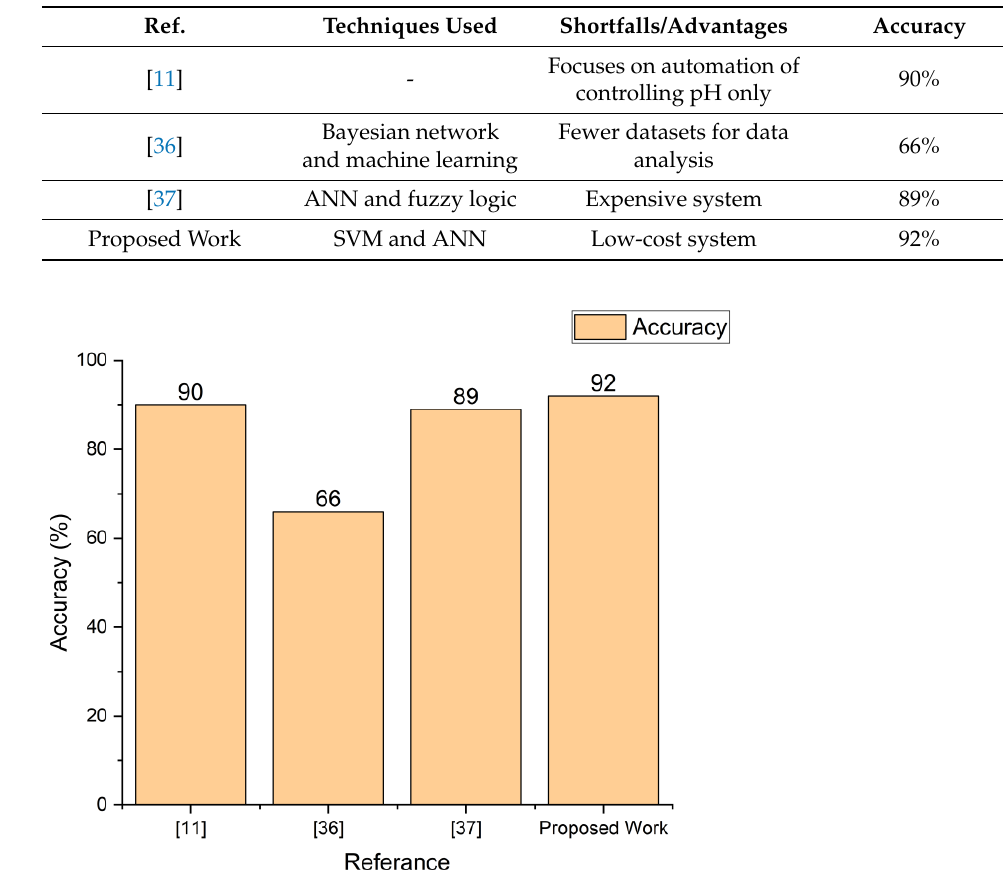
Figure 20. Representation of accuracy value in